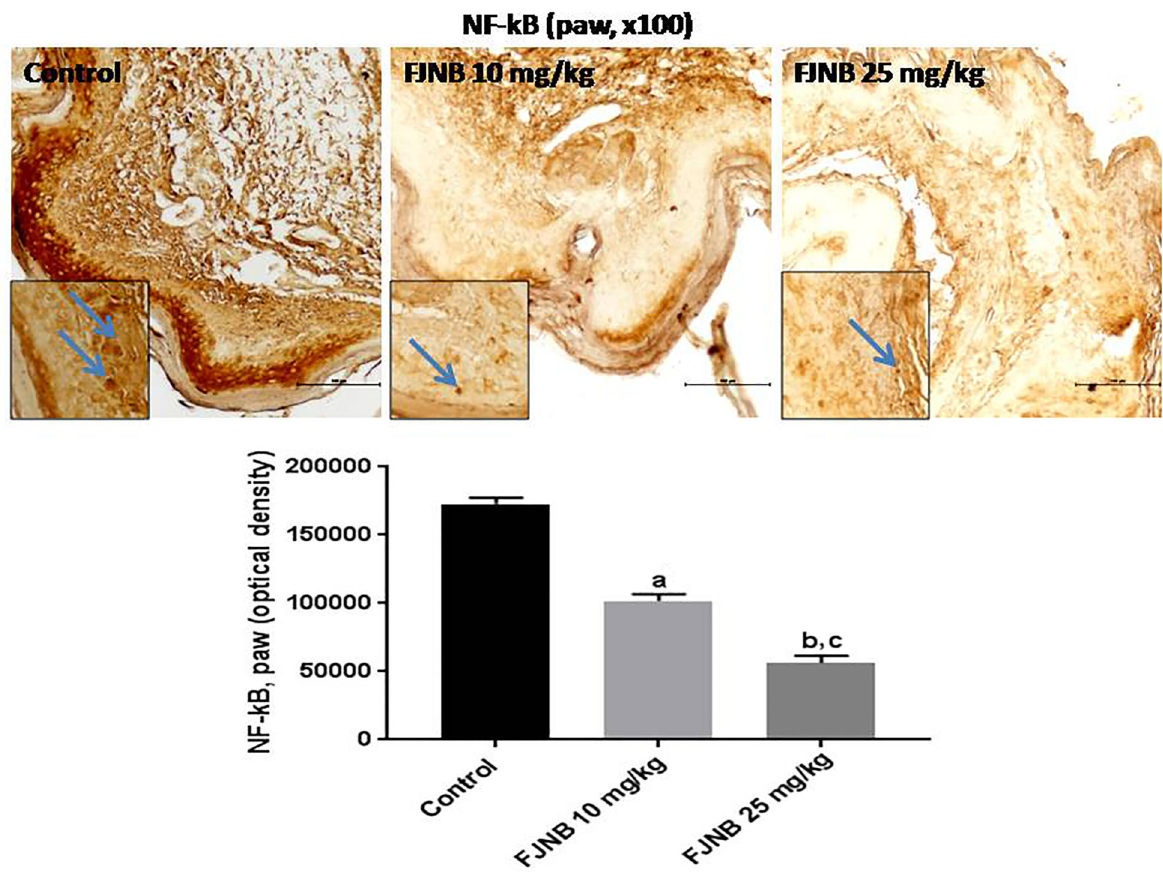
Figure 9. The triterpene-rich fraction from Himatanthus drasticus (FJNB) inhibited the immunostaining for NF-kB in the in fl amed paws from the formalin test in mice. Representative photomicrographs ( (cid:1) 100 magni fi cation, scale bar, 200 m m). The inserts were taken at (cid:1) 400 magni fi cation and blue arrows show polymorphonuclear cells. Data are reported as means ± SE for 3 different animals. a,b P o 0.0001 vs Control; c P o 0.001 vs FJNB 10 (one-way ANOVA and Tukey ’ s test for multiple